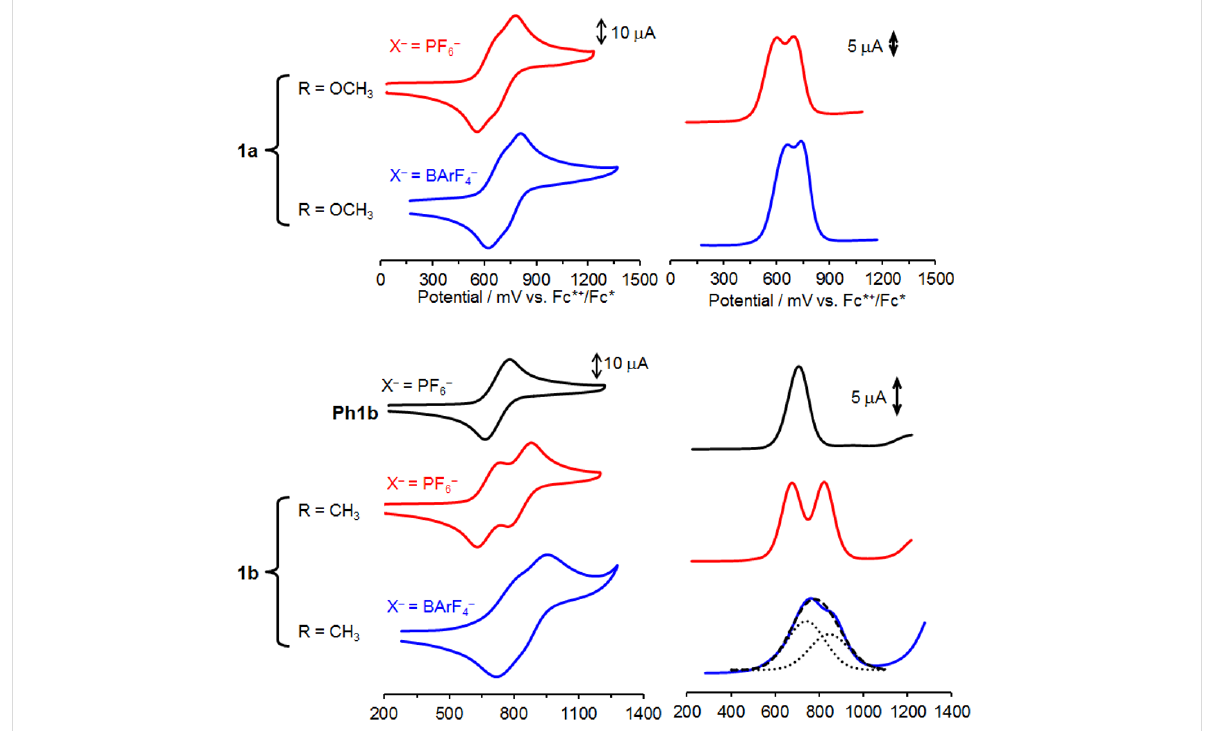
Figure 2: Cyclic voltammograms (left) and differential pulse voltammograms (right) of (top) 1a , (middle) Ph1b, and (bottom) 1b (1.0 mM) in CH 2 Cl 2 containing n -Bu 4 NX (0.10 M). Scan rate: 100 mV s − 1 . For the differential pulse voltammogram of 1b with BArF 4 − , Gaussian deconvolution (black dotted line) and the sum (black dashed line) were also shown.